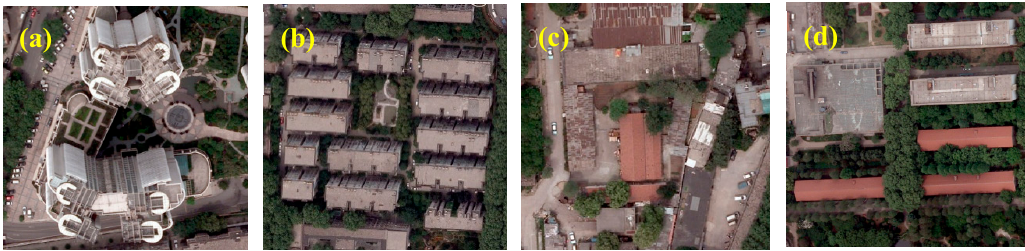
Figure 2. Four different types of buildings: ( a ) high-rise buildings as rectangle 1 in Figure 1a; ( b ) dense residential area as rectangle 2 in Figure 1a; ( c ) shantytowns as rectangle 3 in Figure 1a; and ( d ) buildings surrounded by dense trees as rectangle 4 in Figure 1a.